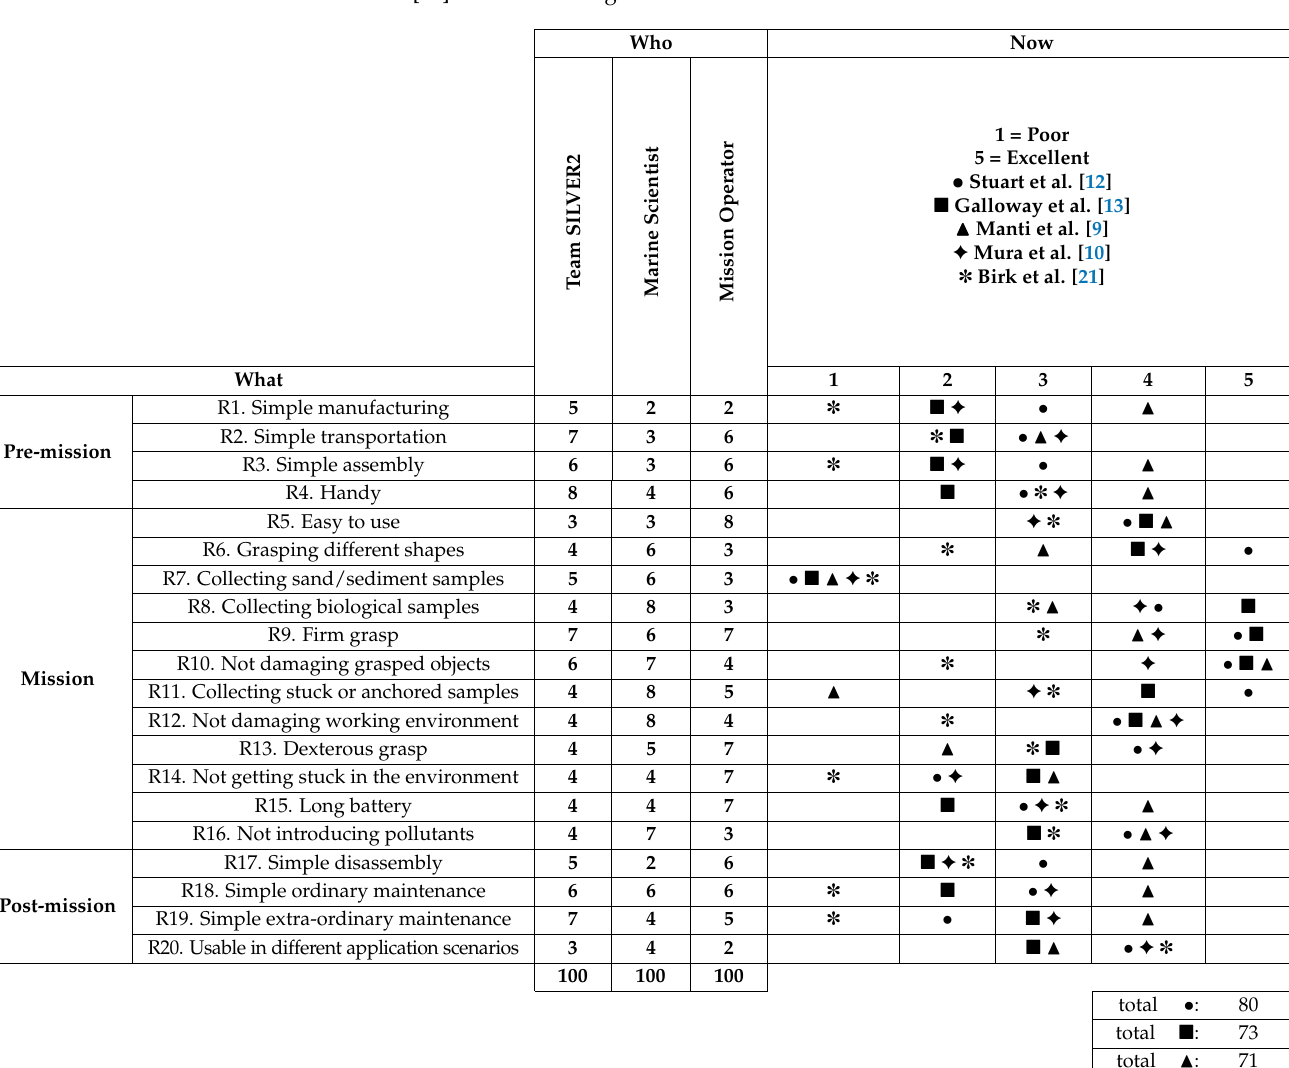
Table 1. Requirements for the development of the soft gripper resulting from interviews with the team of developers, a marine scientist, and a mission operator/ROV pilot. Five prototypes in the state-of-the-art [9,10,12,13,21] have been evaluated against the requirements collected, and the Ocean One hand [12] obtained the highest